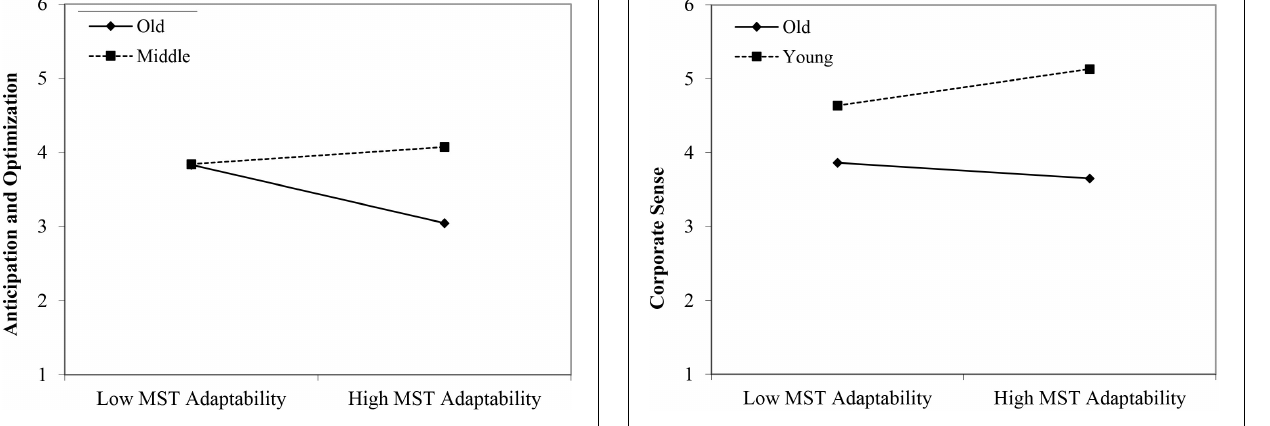
FIGURE 9 | Interaction between perceived age-based (meta-)stereotyping adaptability and age groups: Predicting corporate sense. Low = –1 SD ,